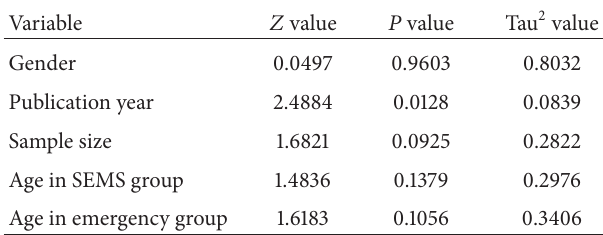
Table 7: Metaregression analysis of overall complication rate of semielective surgery after SEMS installation versus emergency